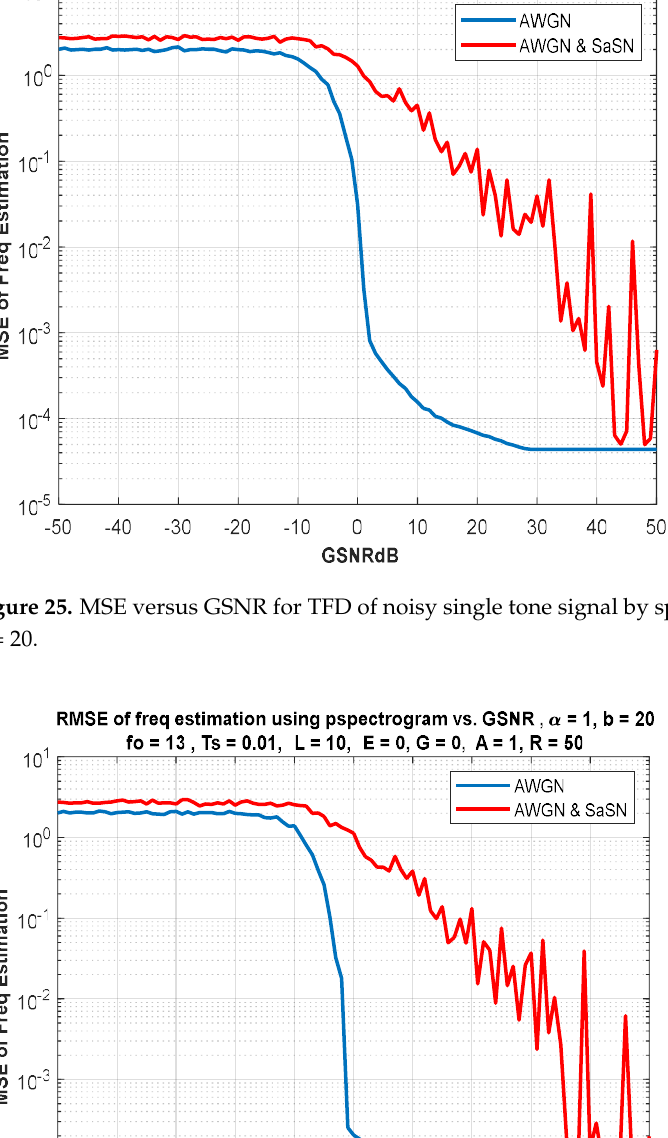
Figure 24. Test error rate for SE of noisy LFM by CNN, where 𝑓 (cid:3042) = 18.001.